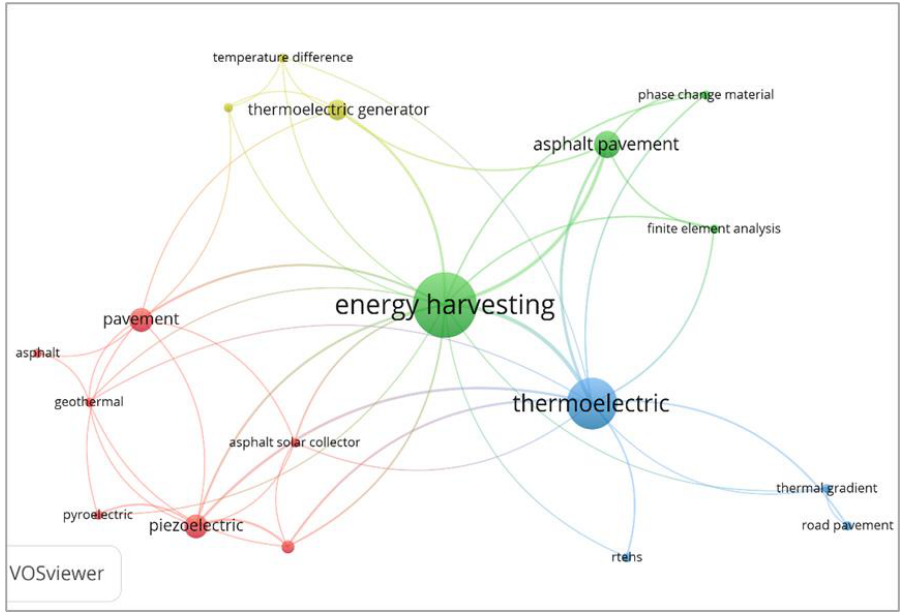
9 of 24 Figure 8. Publication distribution based on the used technique. 3.5. Keywords Bibliometric Mapping and Analyses Bibliometric analysis is one of the tools that can be used to understand the relation- ships between different studies in a certain field [54,55]. In addition, bibliometric mapping allows researchers to understand the research trend and identify gaps and future direc- tions [44]. Therefore, keyword bibliometric mapping was conducted in this study. For a certain research domain, keyword bibliometric mapping and analysis may help to provide a general overview of the study by presenting a concise illustration of the con- tents and describe the existing research patterns [56,57]. Herein, VOSviewer software was used to conduct the authors ’ keyword co-occurrence analysis for the selected articles (47 publications). This type of analysis can be used to investigate the progress of the research field over time, as well as to identify the authors ’ commonly used keywords to show their contributions [54]. Among the 47 publications, a total of 127 keywords were found, with 21 keywords meeting the threshold point, as the minimum number of co-occurrences for a keyword was set to 2. Author keyword mapping and the summary of the top 6 key-